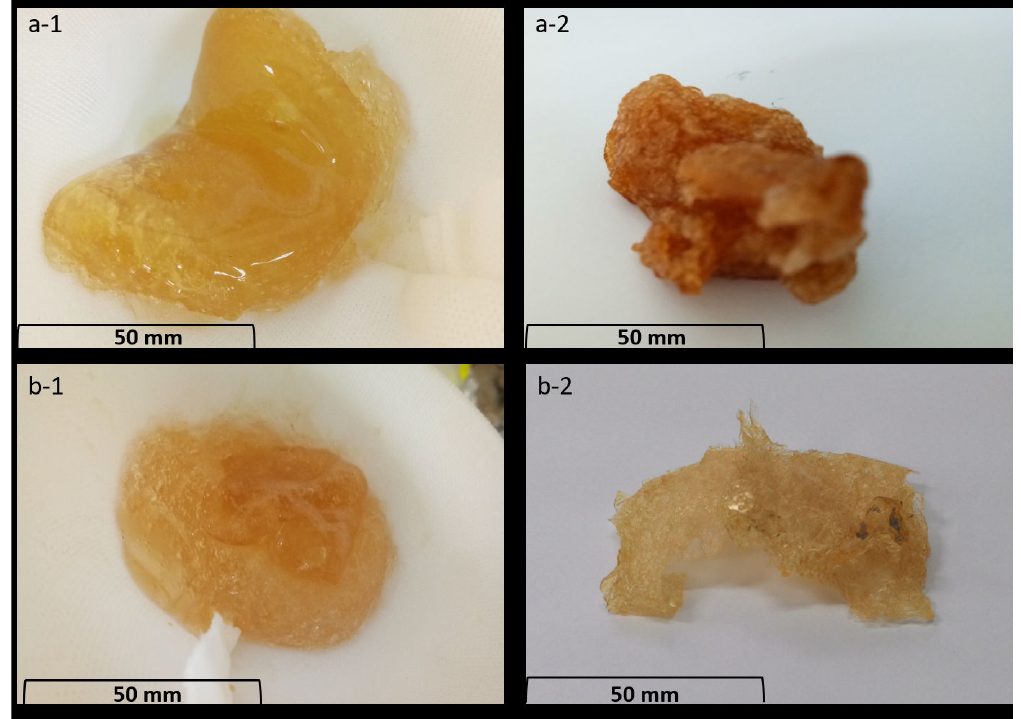
Figure 5. ( a ) Digital images of pectin extracted by ChCl–Mal; a-1 (after filtration), a-2 (after drying). ( b ) Digital images of pectin extracted by ChCl–Glc–W; b-1 (after filtration), b-2 (after